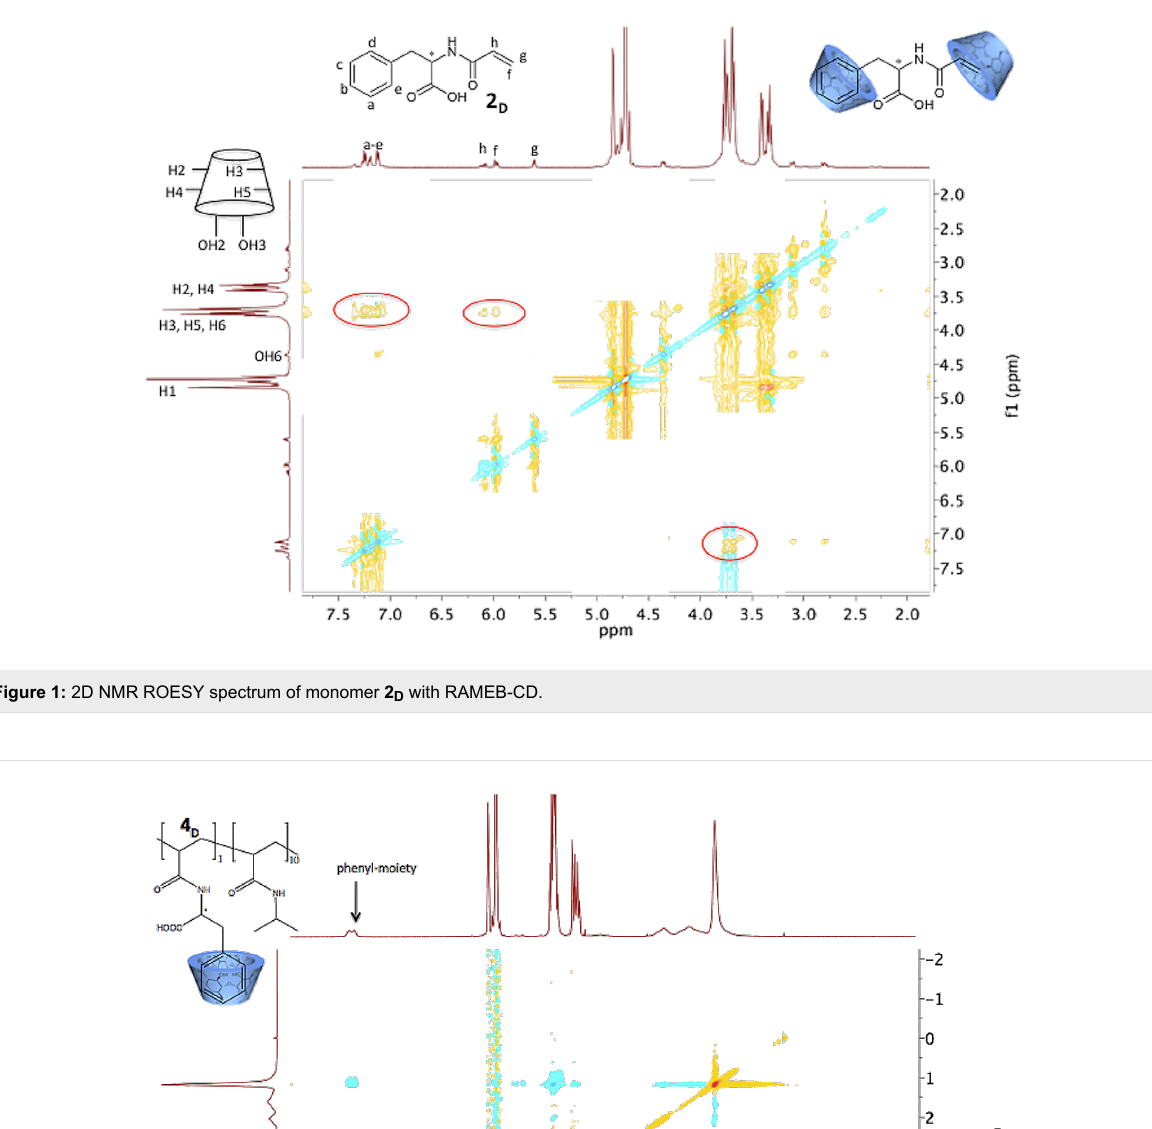
Figure 2: 2D NMR ROESY experiment showing the correlation between protons of the phenyl moiety of 4 D with the β -CD protons.